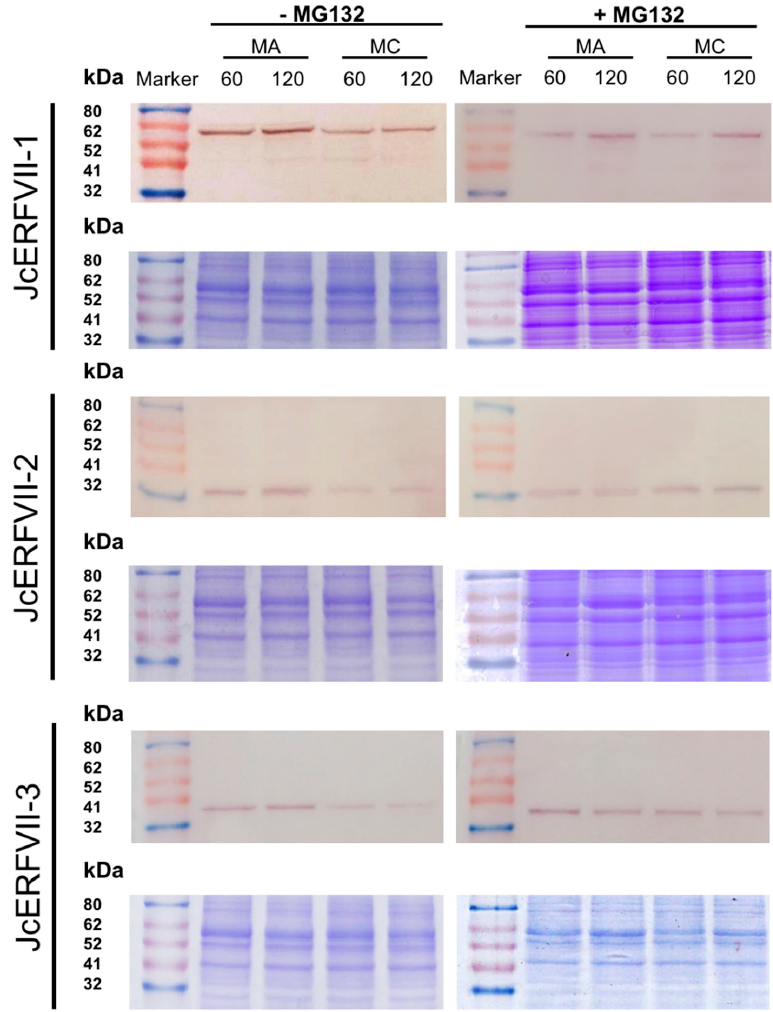
Figure 3. Jatropha ERFVIIs are substrates for the N-end rule pathway in vitro. Western blot analysis of in vitro stability of HA-tagged wildtype (MC) and stable mutation (MA) of JcERFVIIs 1–3 in the absence or presence of proteasome inhibitor (MG132). 60 and 120 indicate incubation time in minutes. Coomassie staining of a similar SDS-PAGE used for western blotting was used as a loading control. 2.4. Overexpression of the JcERFVII2 Enhanced Low Oxygen Tolerance in Arabidopsis Based on previous studies, among the five members of the Arabidopsis ERFVIIs , the role of RAP2.3 in low oxygen responses has been less explored. Therefore, we aim to characterize JcERFVII2 function towards low oxygen response. To investigate the function of JcERFVII2 in providing tolerance to low oxygen stress and whether modulation of its stability could affect the stress tolerance, we generated transgenic Arabidopsis lines overexpressing MA- or MC-JcERFVII2 driven by the CaMV35S promoter. Ten and 5 transgenic lines overexpressing MA- and MC-JcERFVII2 were generated and 4 independent homozygous lines, 3 5S:MA-JcERFVII2-1 (MA-Line1), 35S:MA- JcERFVII2-7 (MA-Line7), 35S:MC-JcERFVII2-3 (MC-Line3), and 35S:MC-JcERFVII2-5 (MC-Line5),